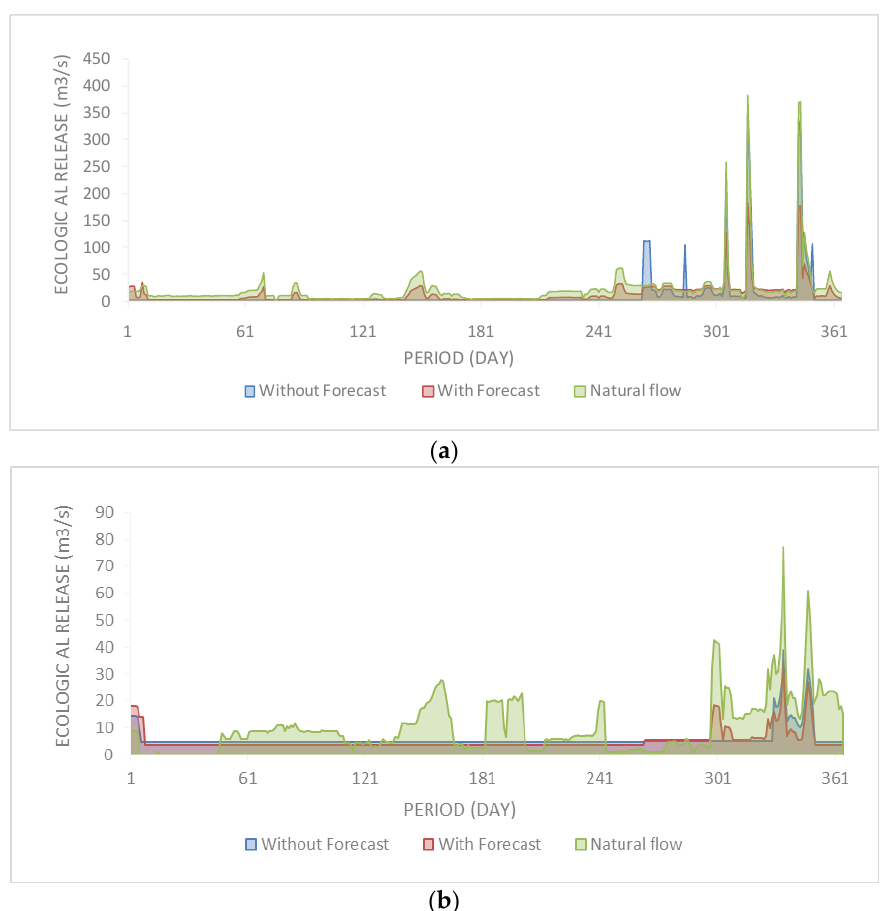
Figure 8. Comparison of ecological releases, between those with and without a long-term forecast. ( a ) Comparison of wet years; ( b ) Comparison of dry years.